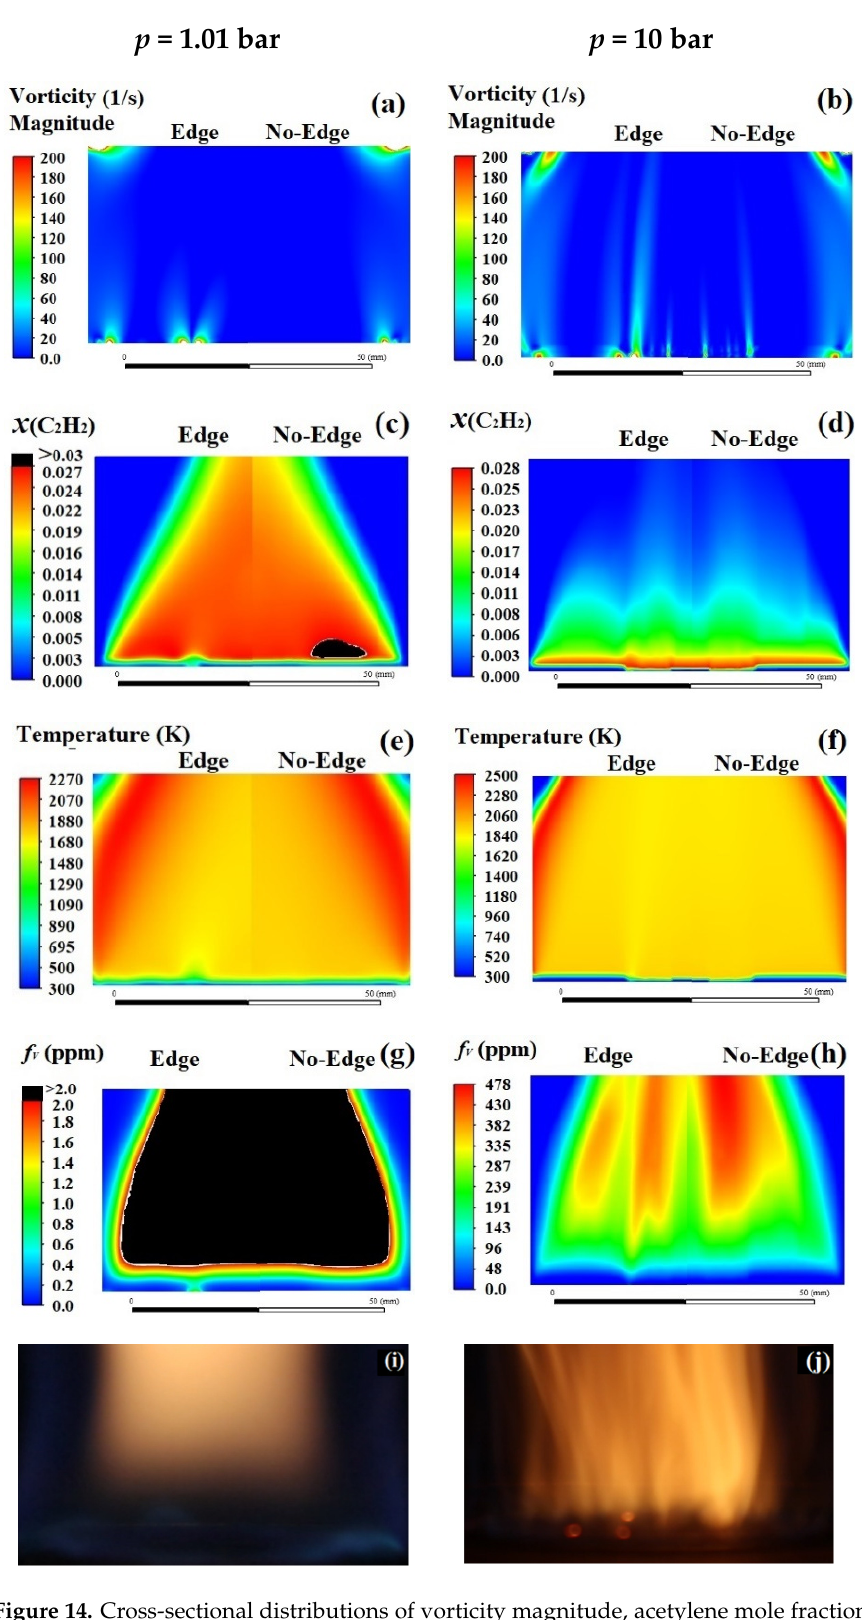
Figure 14. Cross-sectional distributions of vorticity magnitude, acetylene mole fraction, f V (ppm), and gas temperature (K) of the target flame C 2 H 4 /air φ = 2.1 of diameter 56 mm with and without edge, and photos of the same target flame but with diameter of 20 mm shielded by a non-sooting flame of CH 4 /air φ = 1.2 at p = 1.01 and 10 bar.